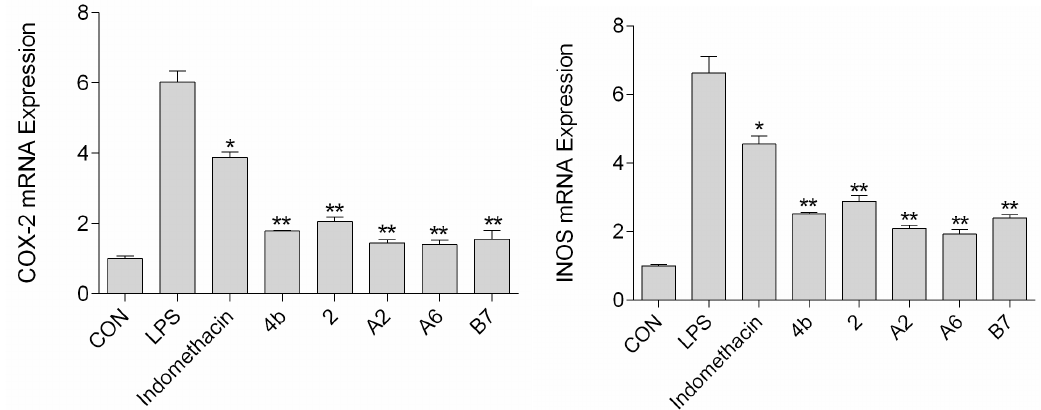
Figure 6. The expression of COX-2 and iNOS mRNA after treatment with 10 μ M compound 4b , 2 , A2 , A6 , B7 , or indomethacin (*: p < 0.05; **: p < 0.01).